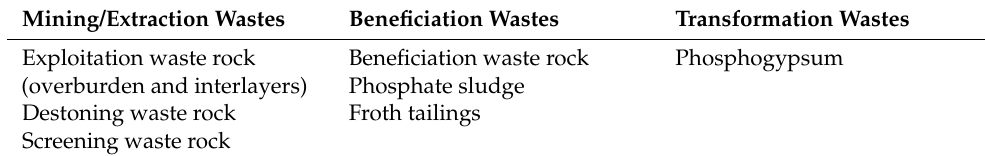
Table 1. Main solid waste streams in the phosphate supply chain.